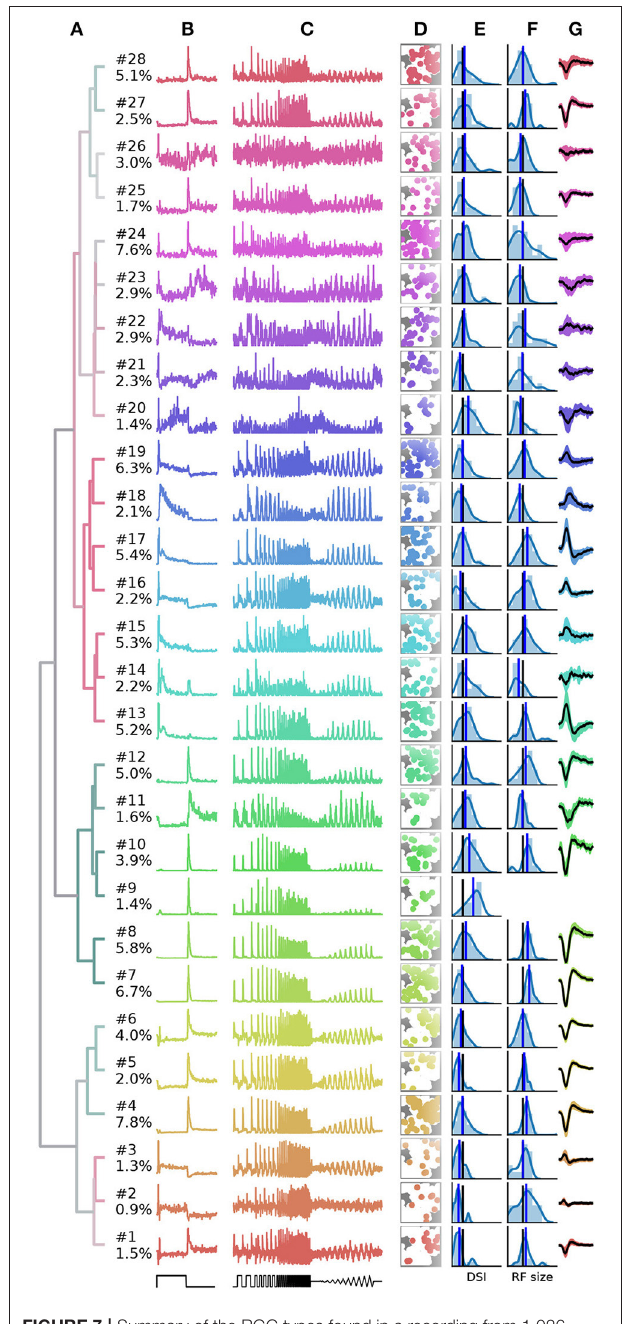
FIGURE 7 | Summary of the RGC types found in a recording from 1,026 retinal ganglion cells (RGCs). (A) , Dendrogram, with lines colored according to the average bias index of all units with lower distance (green = –1/Off, red = +1/On, gray = Zero). Percentages at the leafs give the relative abundance of each RGC type. (B–G) , Each row shows properties of one cluster: (B) , full field PSTH (2 sec bright, 2 sec dark); (C) , chirp PSTH; (D) , spatial distribution of each cluster, recorded area is indicated in white; (E) , histogram of direction selectivity index (DSi); (F) , histogram of receptive field sizes; (G) , temporal spike triggered average (STA) obtained at the pixel with the largest STA magnitude, shaded area indicates one standard deviation around the mean (black, where missing no receptive field could be fit). In E and F, the black vertical lines are retina averages and blue lines the cluster